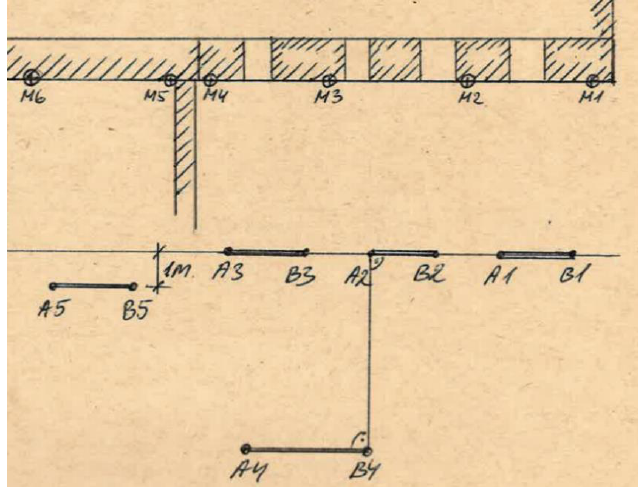
Figure 2. Sketch of original photogrammetric survey in 1991.